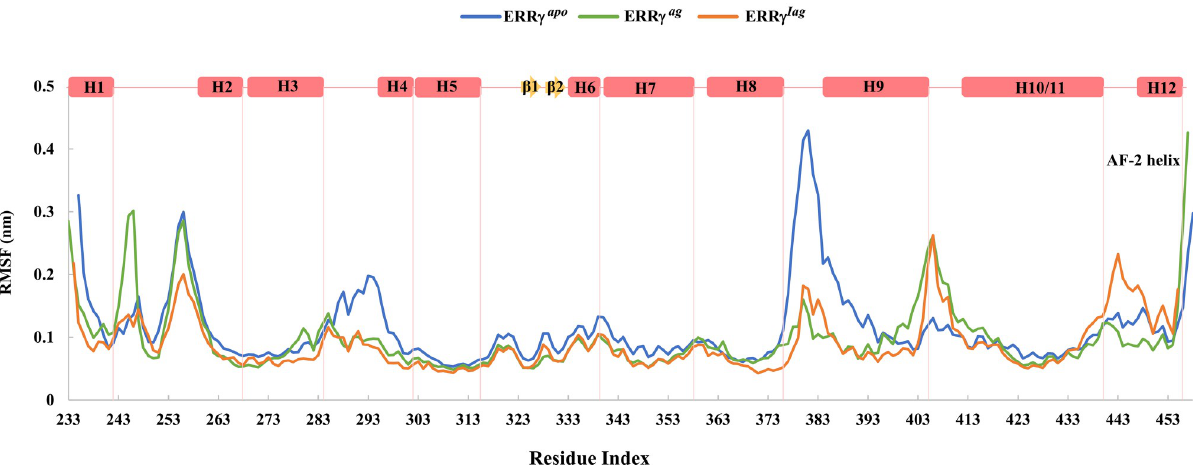
Fig 3. Root mean square fluctuation (RMSF) of ERR γ apo , ERR γ ag and ERR γ iag : RMSF of the backbone atoms of ERR γ apo , ERR γ ag and ERR γ iag